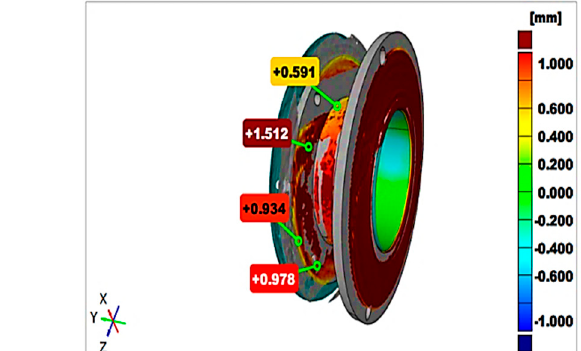
Figure 8. Three − dimensional Part Scan. Red areas represent the scanned part that are bigger than the 3D part, Green areas represent the scanned part is equal with 3D part, Blue areas are showing that the scanned part is smaller than the 3D part.